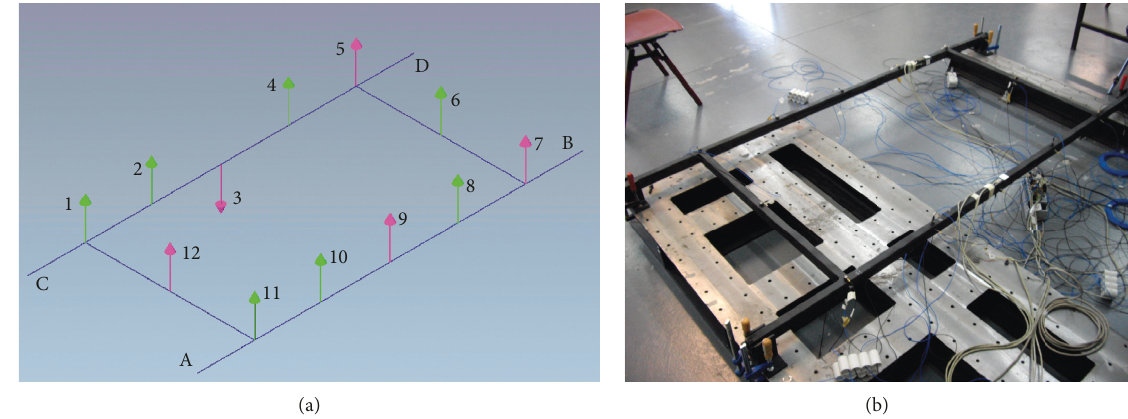
Figure 15: Test setup used in the experimental